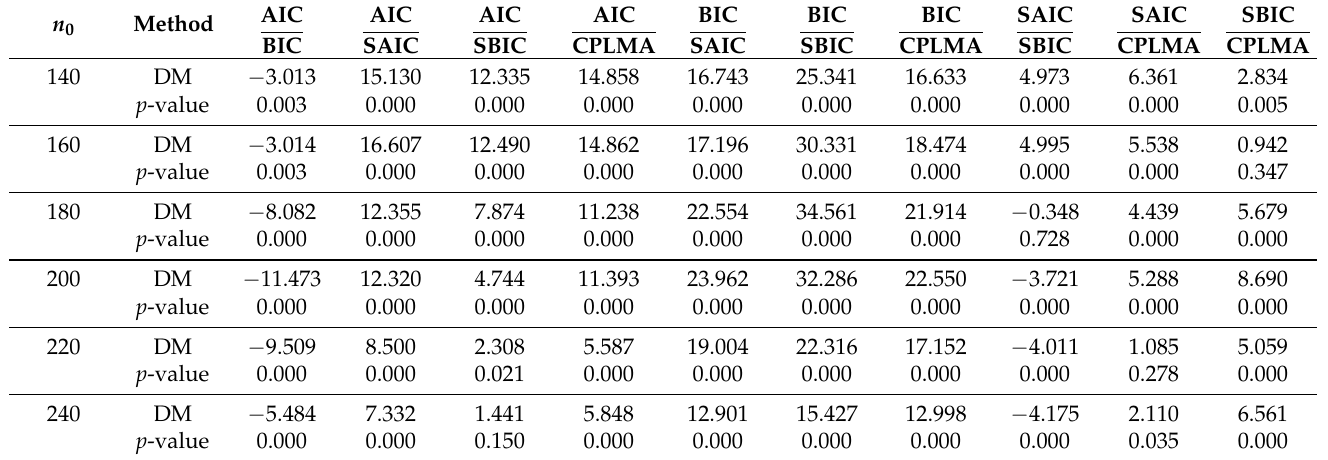
Table 3. Diebold–Mariano test results for the differences in MSPE.